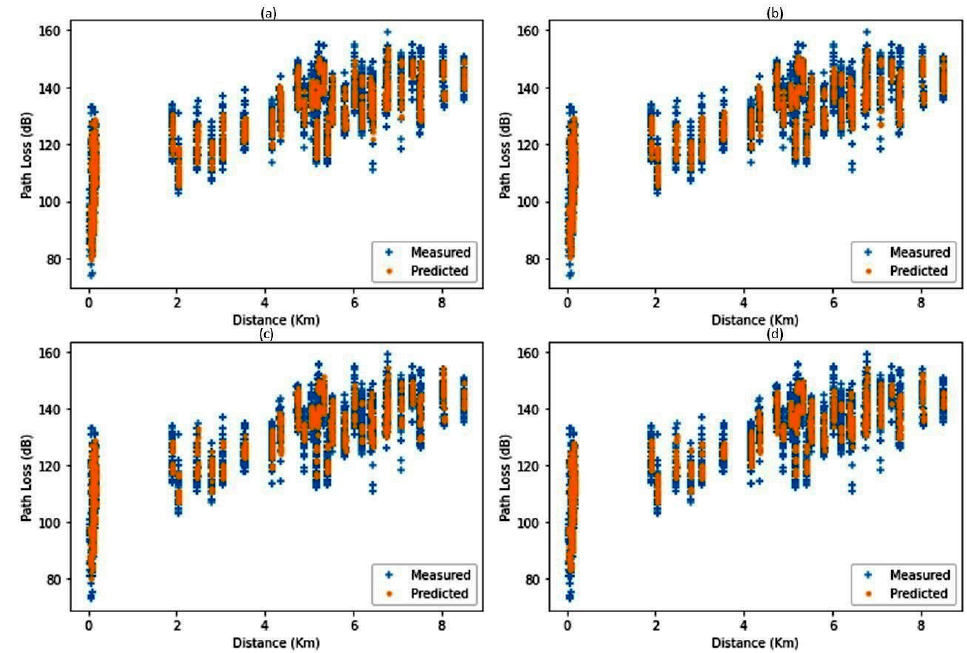
Figure 20. Predictions in urban highrise environment based on ( a ) DRS on dataset 1, ( b ) DES on dataset 1, ( c ) DRS on dataset 2, ( d ) DES on dataset 2.